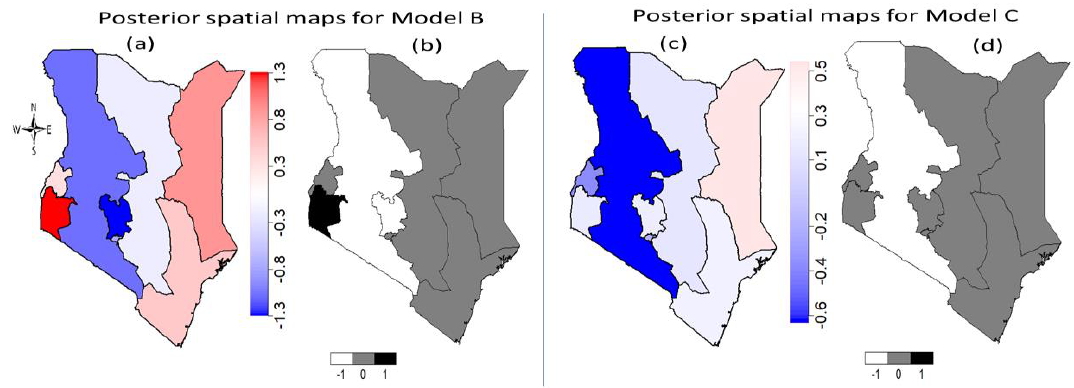
Figure 4. Posterior risk maps [( a ) and ( c )] of Kenyan 0–14 years old girls’ FGM / C with the corresponding 95% (right) [( b ) and ( d )] posterior significance maps for Model B (left panel) and Model C (right panel). Deep blue to red corresponds to low risk to high risk. Black colour indicates significantly high-risk regions, white colour indicates significantly low risk regions and grey colour indicates nonsignificant regions.